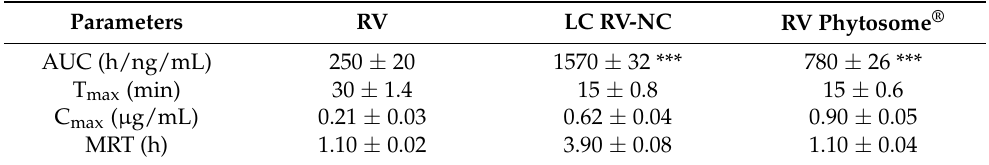
Table 2. Pharmacokinetic parameters of the coarse trans -resveratrol suspension (RV), lipid-coated trans -resveratrol nanocrystals (LC RV-NC) and RV Phytosome ® . The results are expressed as the mean ± standard deviation (SD). * p < 0.05; ** p < 0.01; *** p < 0.001 vs.